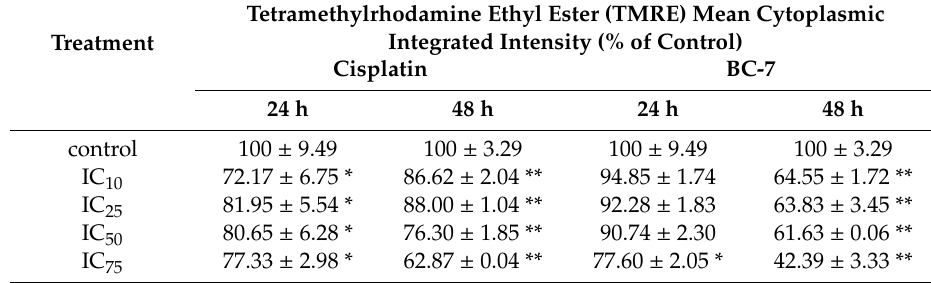
Table 4. Changes in mitochondrial membrane potential (MMP) in HeLa cells after 24 and 48 h of exposure to cisplatin and BC-7.